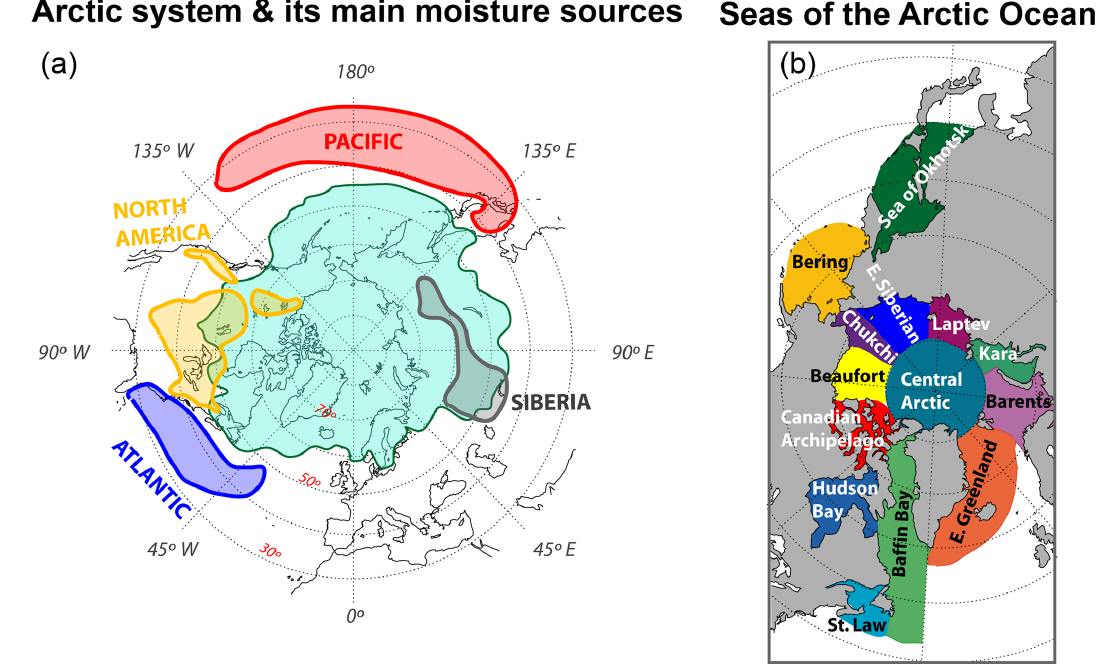
Figure 1. (a) The Arctic region (AR) using the definition of Roberts et al. (2010) (light blue region) together with the major moisture sources for the Arctic as detected by Vazquez et al. (2016) and named Atlantic (dark blue region), Pacific (red region), North America (yellow region), and Siberia (grey region). (b) The Arctic Ocean (AO) and its main